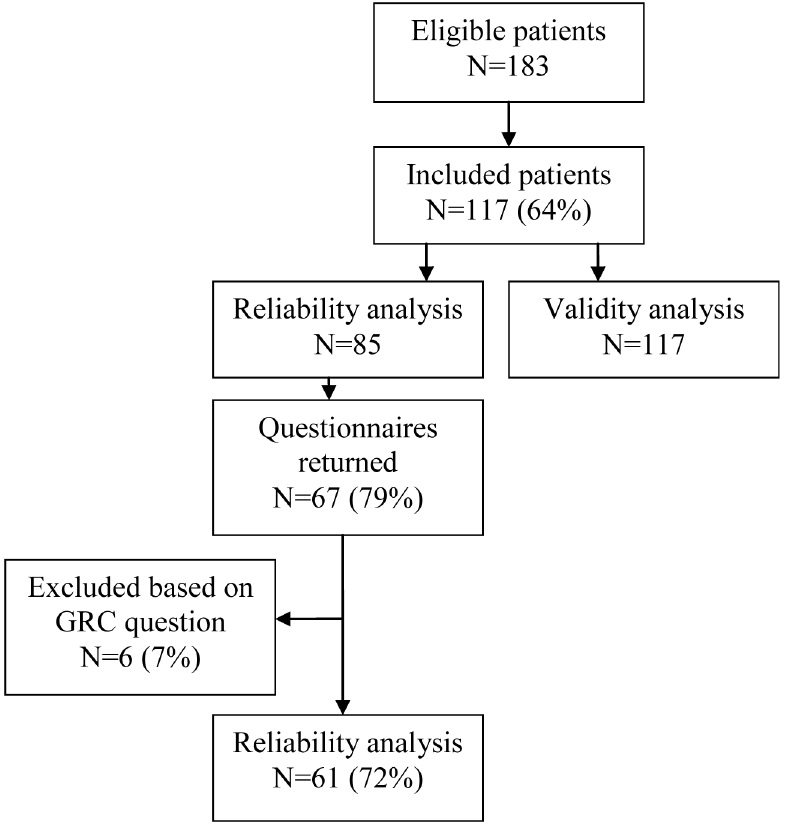
Fig 1. Flow diagram of inclusion of participants. Abbreviation: GRC, globalrating of